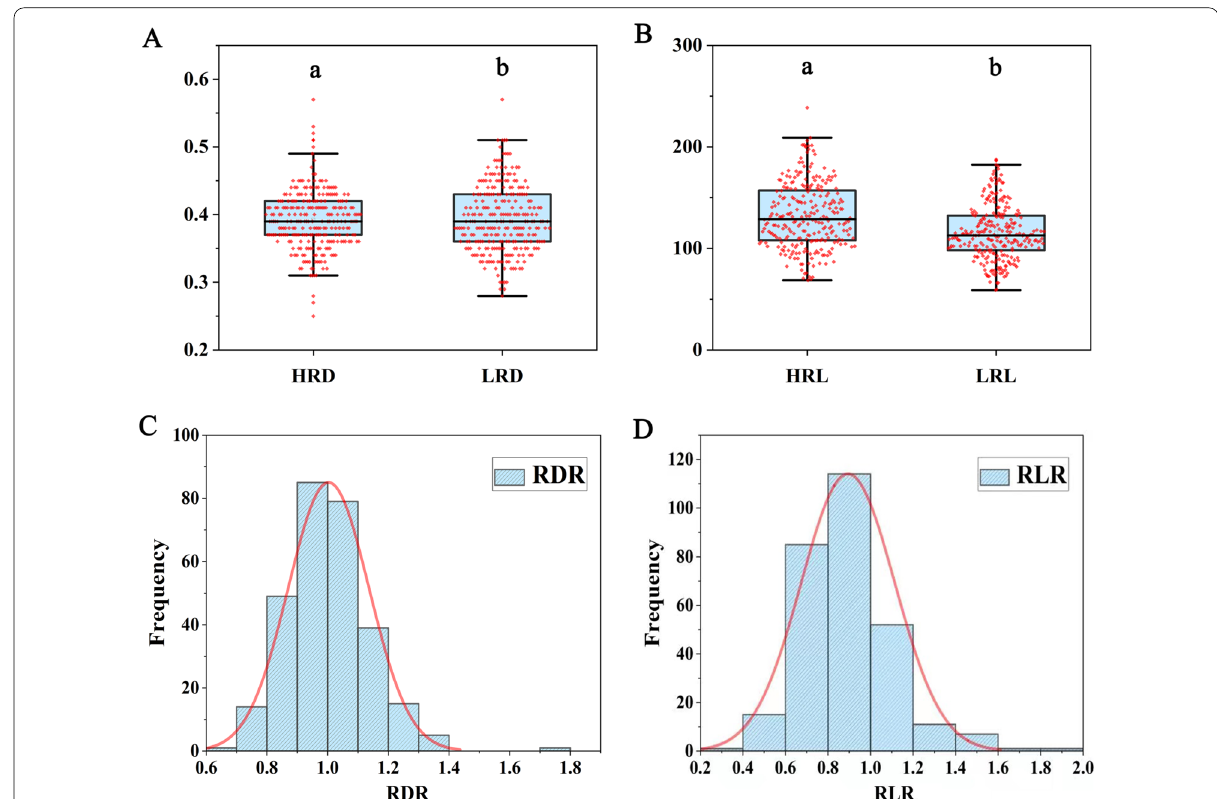
Fig. 1 Phenotype distribution of root morphology traits of 295 rice varieties under low and high nitrogen treatments. A HRD: root diameter under high-nitrogen treatment. LRD: root diameter under low-nitrogen treatment. B HRL: root length under high-nitrogen treatment. LRL: root length under low-nitrogen treatment. C RDR: relative value of root diameter under low and high nitrogen treatments. D RLR: relative value of root length under low and high nitrogen